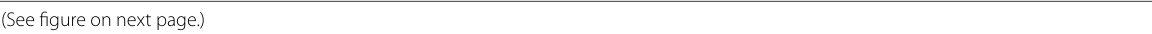
sensors(See figure on next Fig. 1 a Index map showing Mt. Ontake (Ontake Volcano) and river systems in the southern slope. Isopach of fallout and distribution of pyroclastic density currents of the 2014 eruption are after Oikawa et al. (2014) and Takarada et al. (2016). These isopach maps are based on the survey points mostly situated at the eastern, northern, and western flanks of the volcano, and very few from the southern part of medial-distal areas. Wire sensors were set at two localities in the Nigorigawa River by the Ministry of Agriculture, Forestry and Fisheries (MAFF) and the Ministry of Land, Infrastructure, Transport and Tourism (MLIT). Published topographical map and DEM (original data from the Geospatial Information Authority of Japan) were processed by Kashmir 3D. b Distribution of the October 2014 lahar (cohesive debris flow) deposits and outcrop localities (see also in a ). Mapping is based on the authors’ ground survey and captured aerial photo-images taken 2 days after the lahar (Courtesy to Google Earth). c Longitudinal profiles of the Akagawa and Nigorigawa Rivers and distribution of the October 2014 lahar deposits and installed wire